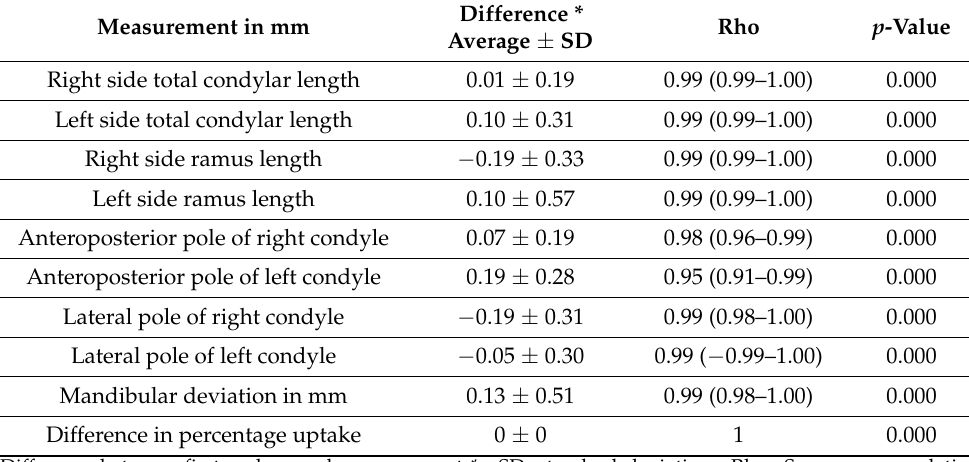
Table 2. Intraobserver agreement for craniofacial measurements obtained in frontal and sagittal